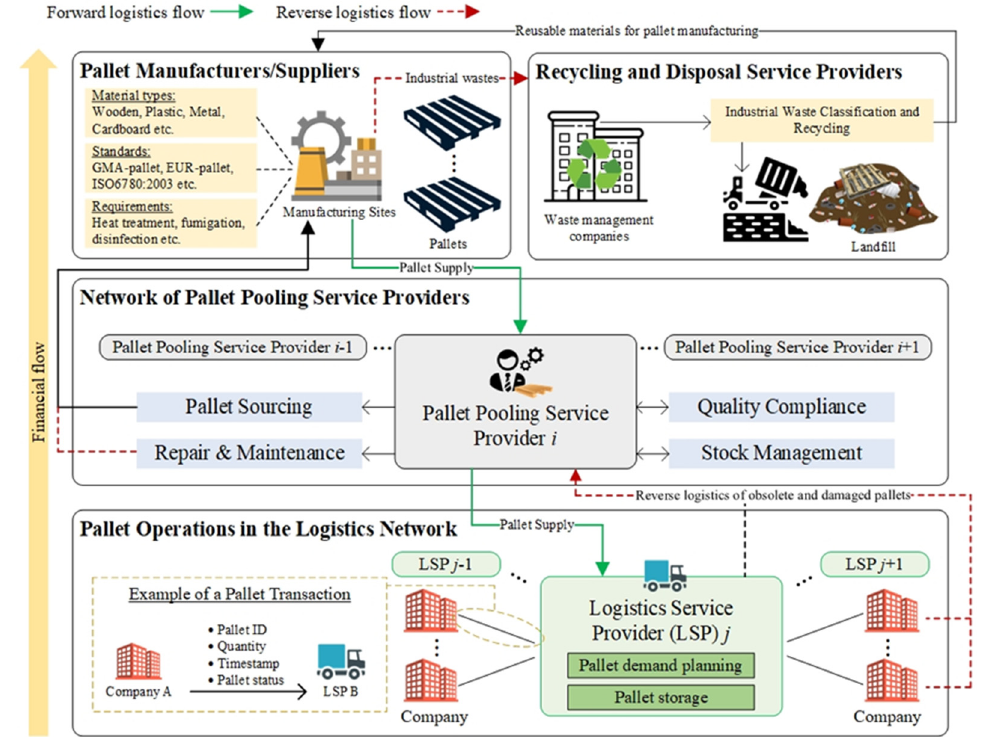
Figure 3. Schematic diagram of the business model of PalletaaS.